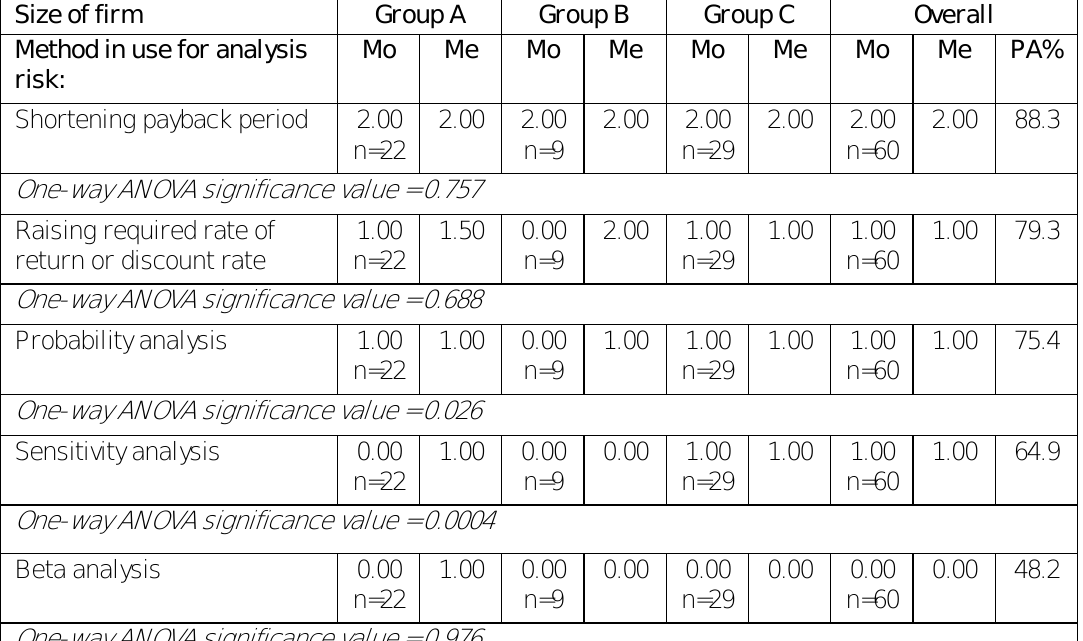
Table 3: Comparisons of usage of risk appraisal techniques Size of